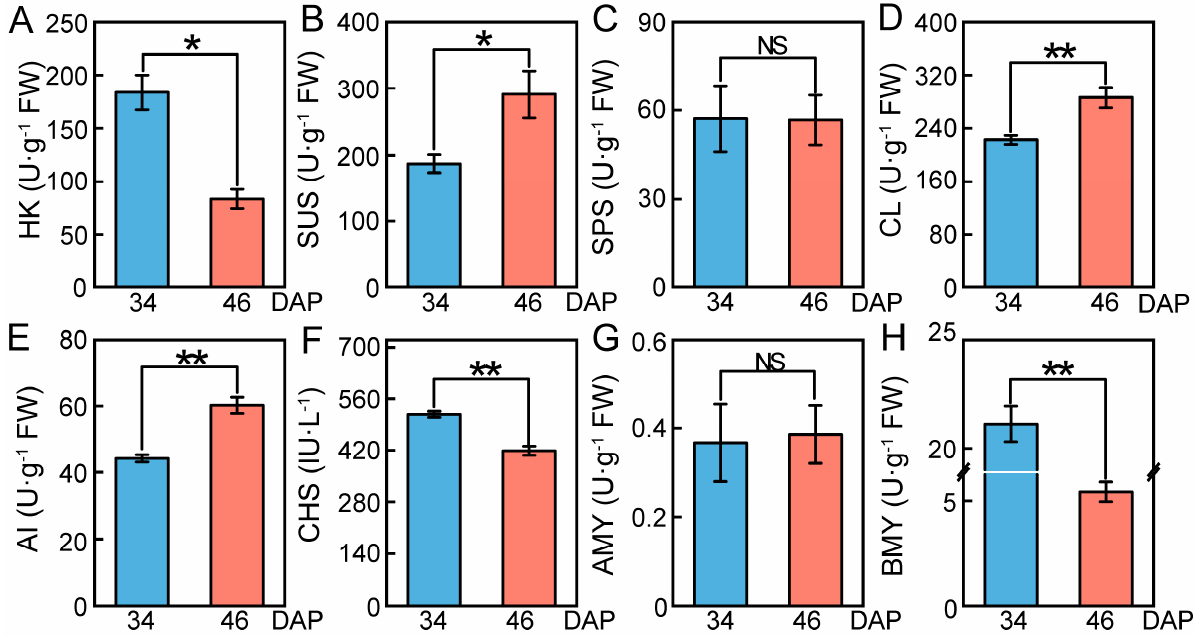
Figure 8. Enzyme activities in wucai leaves at 34 DAP and 46 DAP. ( A ) Hexokinase (U·g − 1 FW). ( B ) Sucrose synthase (U·g − 1 FW). ( C ) Sucrose phosphate synthase (U·g − 1 FW). ( D ) Cellulase (U·g − 1 FW). ( E ) Acid convertase (U·g − 1 FW). ( F ) Chalcone synthase (IU·L − 1 ). ( G ) α− amylase (U·g − 1 FW). ( H ) β - amylase (U·g − 1 FW). Values presented are the mean ± SE (n ≥ 3), * p < 0.05, ** p < 0.01 and NS indi- cated no significant difference between bars.